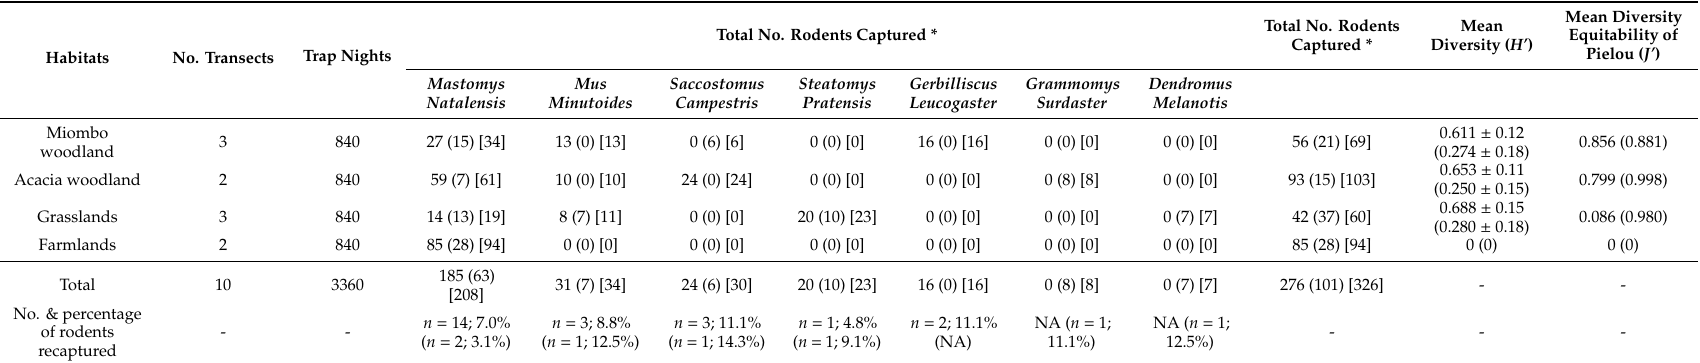
Table 1. Numbers of captured rodents in wet and dry seasons across habitat types in Chembe Bird Sanctuary landscape, Zambia, in 2018–2019.